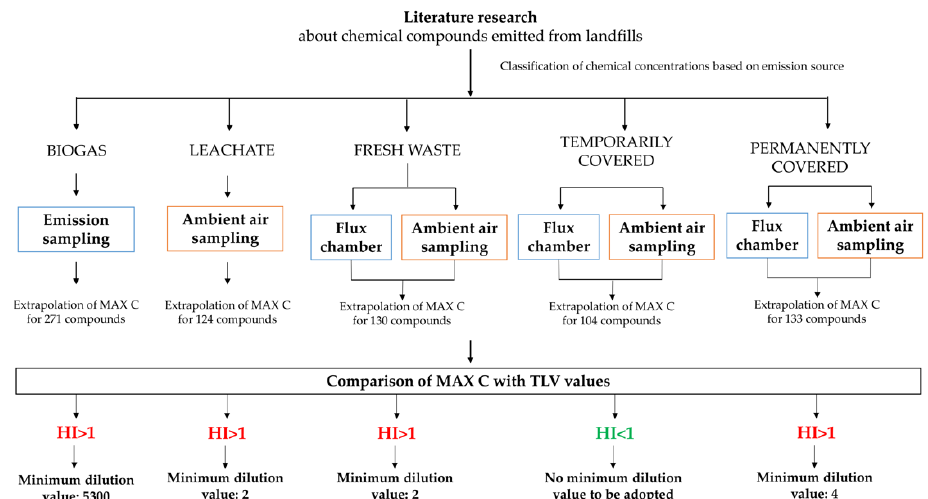
Figure 2. Schematization of the global approach applied for data analysis and the determination of the minimum dilution values. This study proves that the most important pollutant to be investigated for the evaluation of the non-carcinogenic toxicological impact is hydrogen sulphide. Indeed, the HQ relevant to this compound makes a non-negligible contribution to the overall HI for most landfill odor sources. Nonetheless, it is important to highlight that the odor threshold (OT) of this pollutant is very low (0.00041 ppm) [65], thus making it detectable at very low concentrations. Indeed, the comparison of its OT value (from [65]) and TLV (from ACGIH database), reported in Table 7, shows that hydrogen sulphide can be perceived by panelists before producing any adverse effect on human health